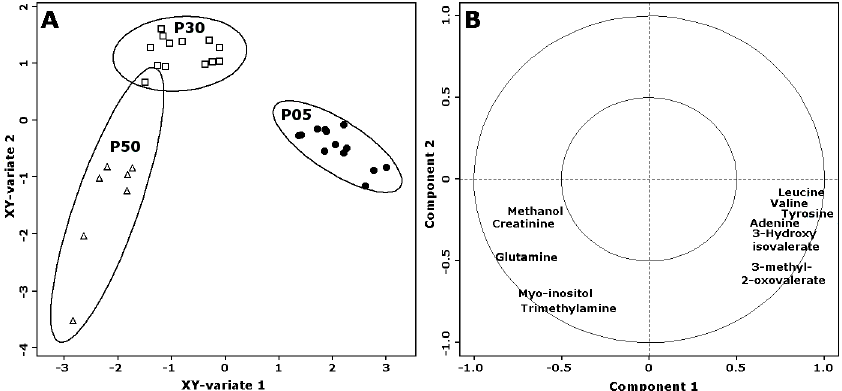
Fig 3. Scoreplot (A) and correlation plot (B) of one of the PLS-DA models built. The base of data was represented by the centered and scaled concentrations of the 11 molecules showing statistically significant differences between P05 and P50. The inner and outer circles of the correlation plots represent correlations of 0.5 and 1 respectively. P05, P30 and P50 samples are represented with filled circles, empty squares and empty tringles